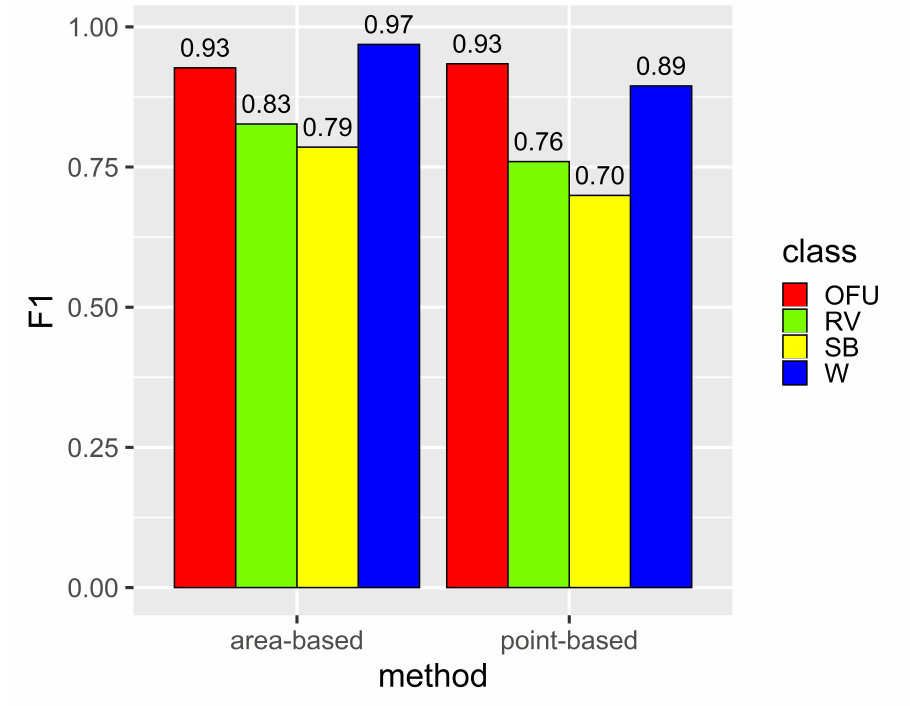
Figure 15. Global per-class F1 scores for the point-based and area-based